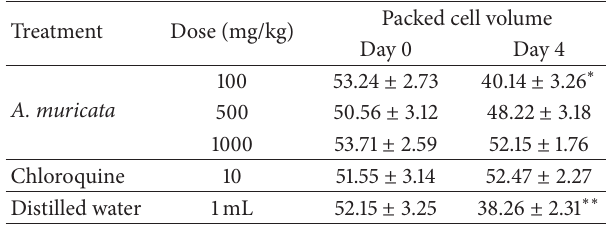
Table 2: Effect of A. muricata aqueous leaf extract on packed cell